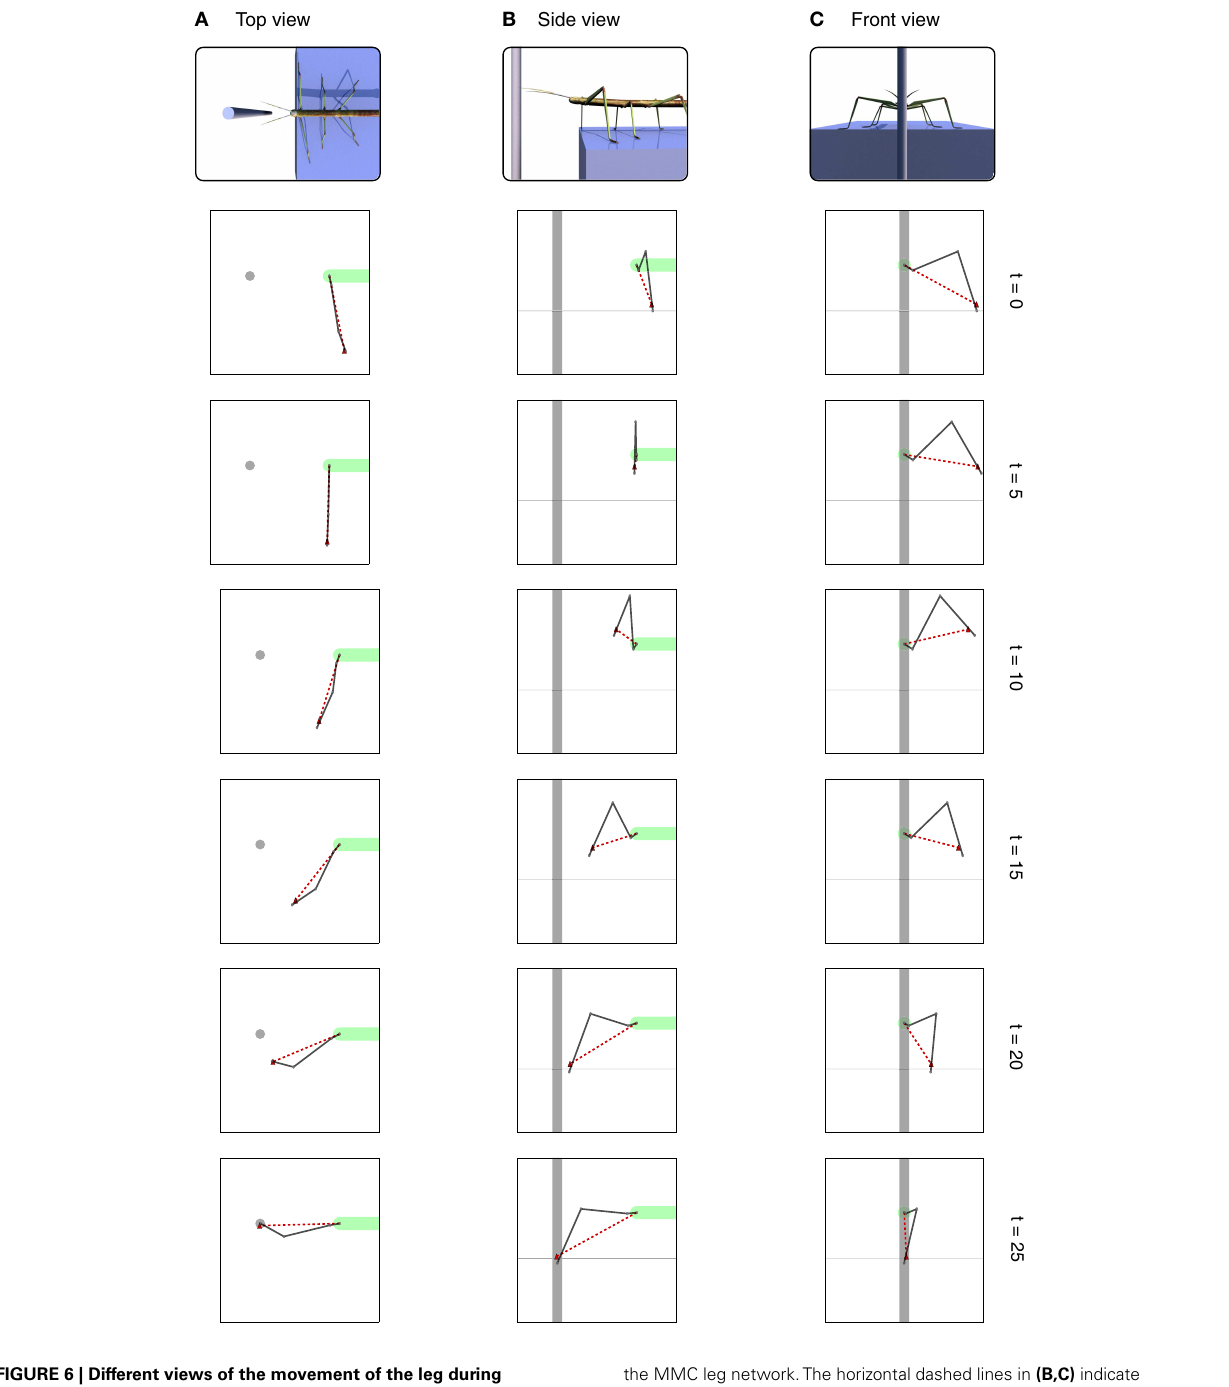
the MMC leg network.The horizontal dashed lines in (B,C) indicate the ground level.View from above is shown in (A) , side view is shown in (B) and view from the front is shown in (C) . Right: number of iterations.